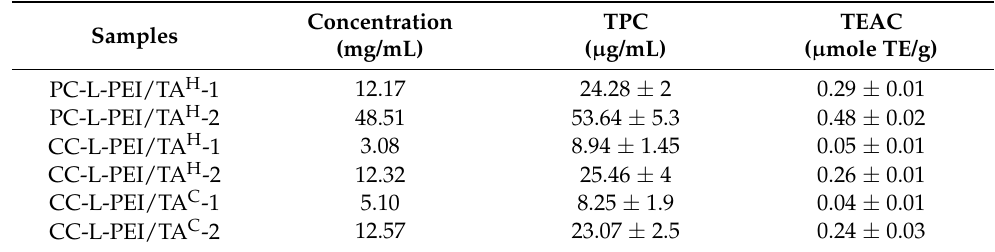
Table 2. Antioxidant activity of L-PEI-based materials, TPC value, and TEAC (determined as the antioxidant activity of the released TA from the materials within 3 h at 37 ◦ C). Concentration TPC TEAC Samples (mg/mL) ( µ g/mL) ( µ mole TE/g) PC-L-PEI/TA H